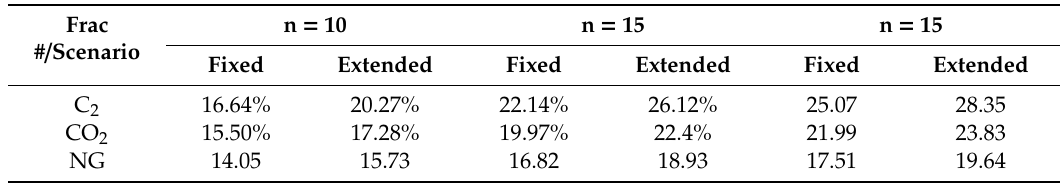
Figure 9. Average reservoir pressure after one year of natural depletion for different fracture stages (FS). Table 2. Recovery factors from fixed and extended cycles scenarios at three fracture numbers of 10, 15 and 20 during injection of C 2 , CO 2 and NG.